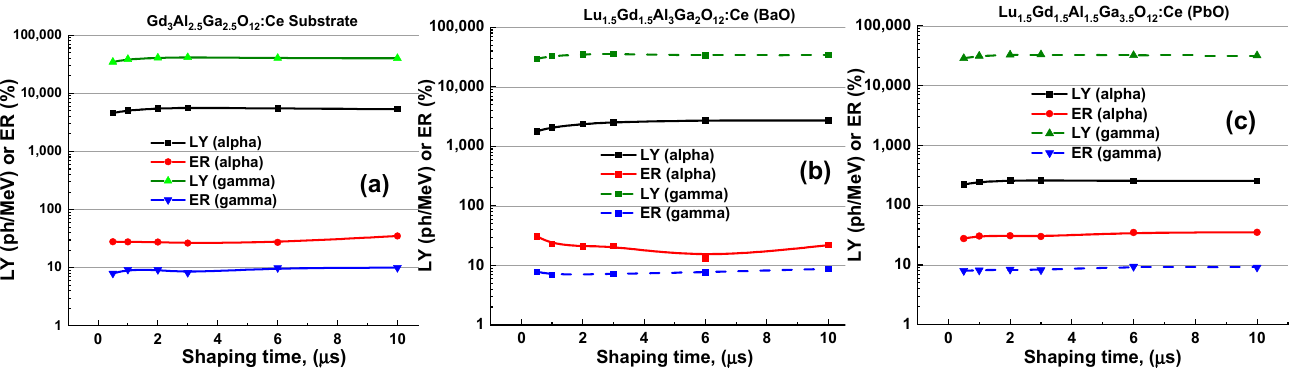
Figure 7. Pulse-height spectra of GAGG:Ce substrate under α -particle ( a ) and γ -quantum ( b ) excitation measured at different shaping times.